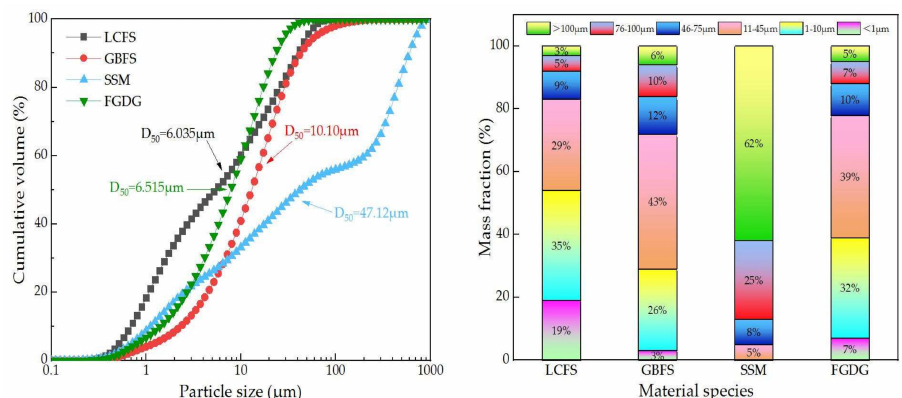
Figure 4. Particle size distribution of raw materials and the percentage of particle size.